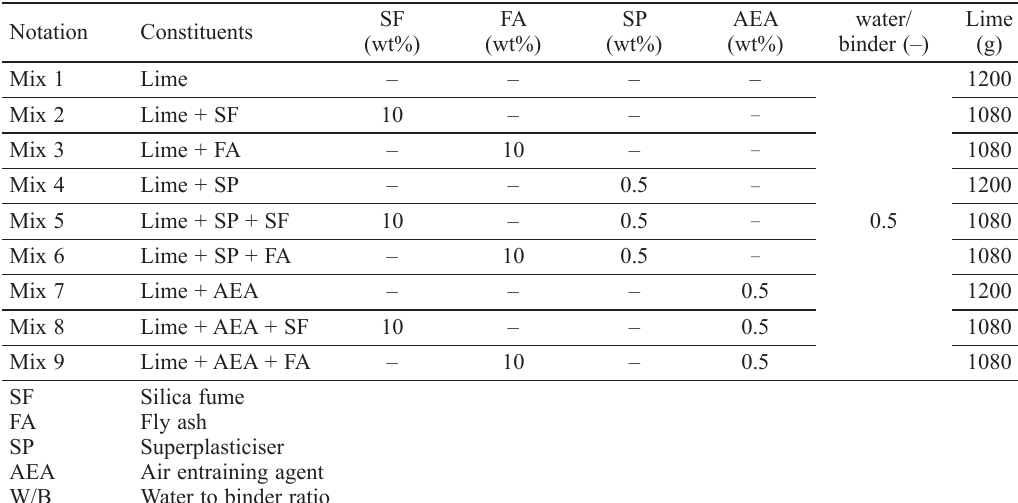
Table 4. Grout mix